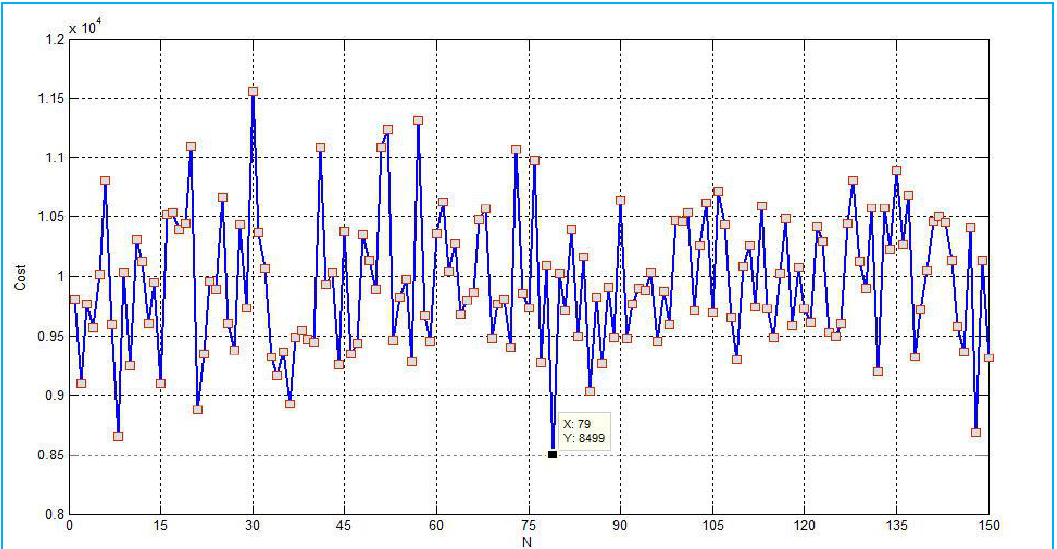
Figure 3. The amount of best costs in various algorithm